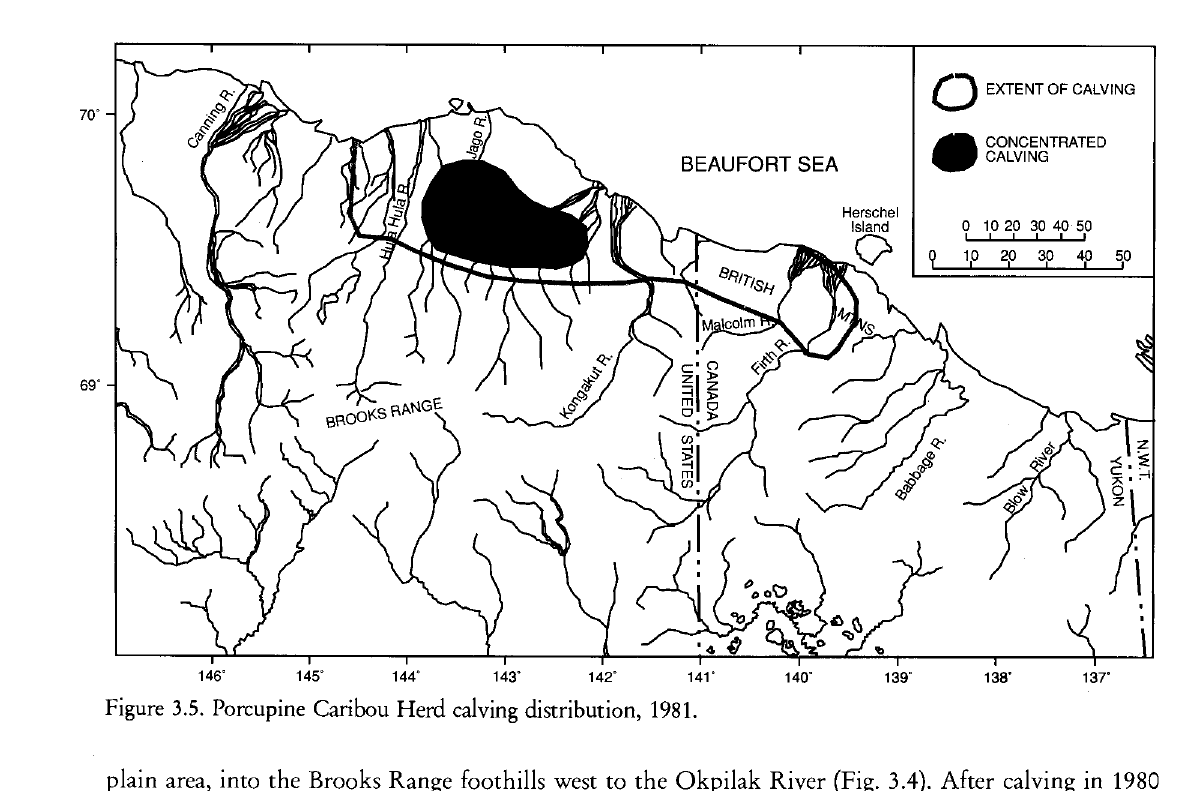
Figure 3.5. Porcupine Caribou Herd calving distribution,